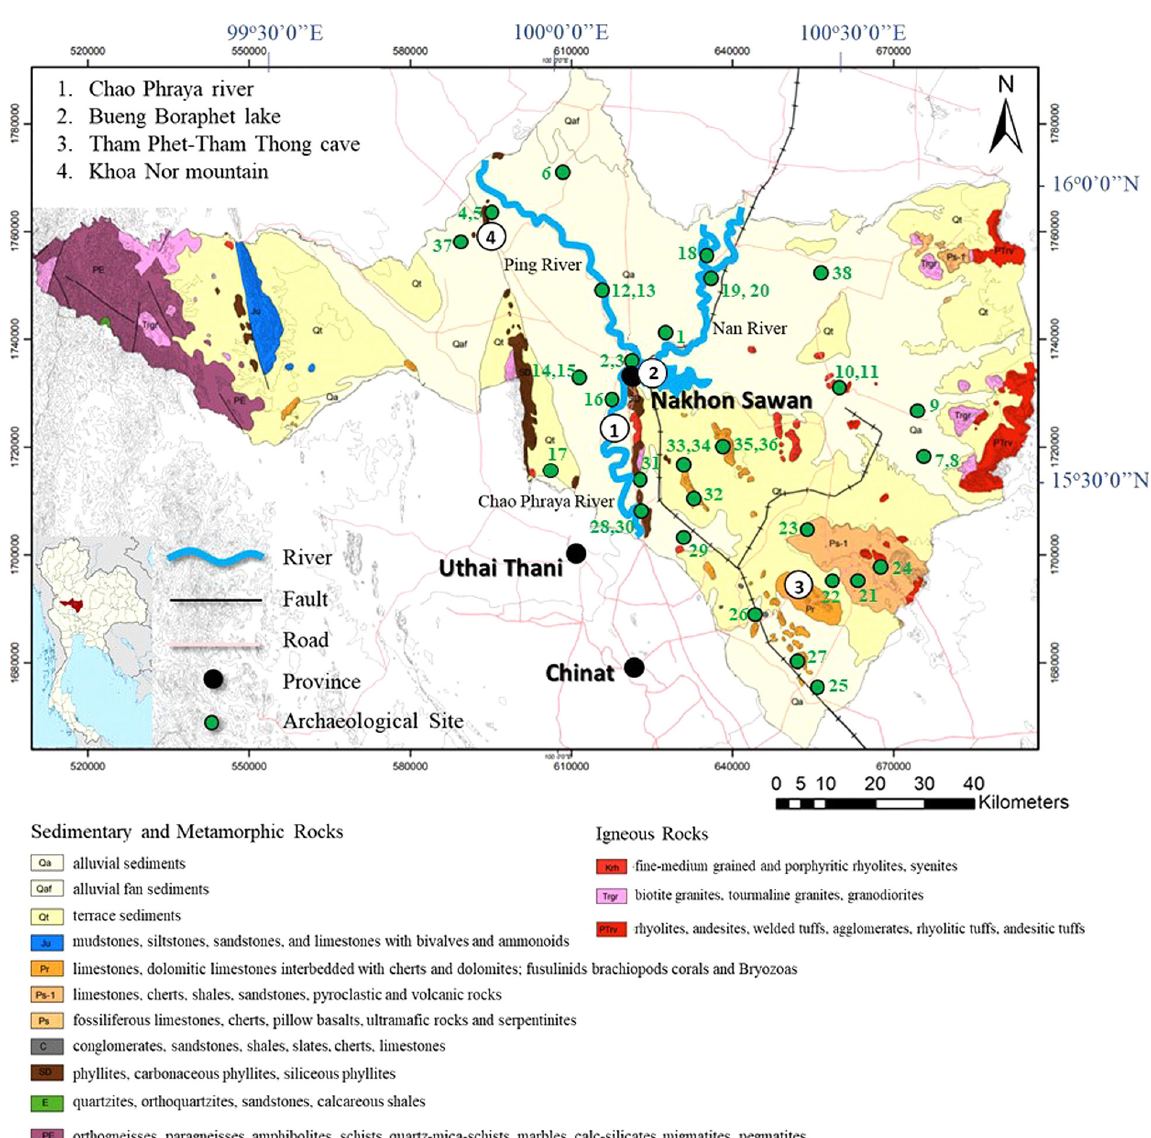
Fig. 1. Archaeological sites distribution in the geologic map of Nakhon Sawan Province. Satellite data taken from ArcGIS ® and geologic data modified from DMR